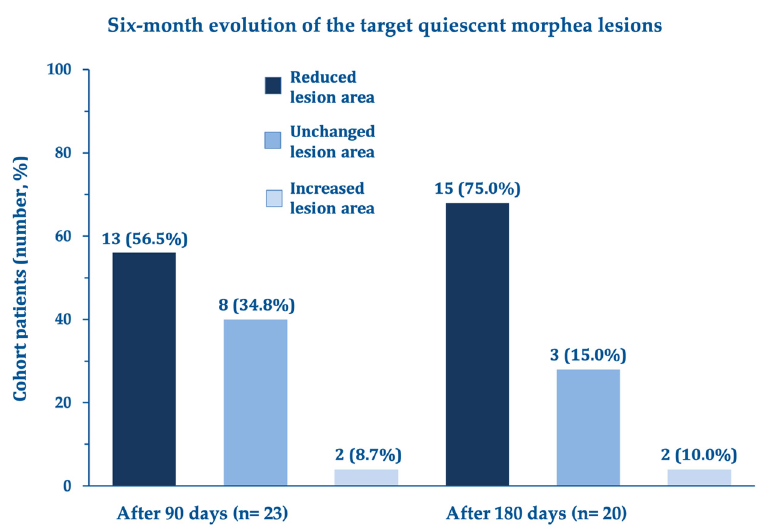
Figure 3. Categorical analysis of changes vs. baseline (screening visit) in the mean area of the three localized scleroderma lesions selected for biopsy after 90 (end ‐ of ‐ treatment visit; n = 23) and 180 days (follow ‐ up visit; n = 20).